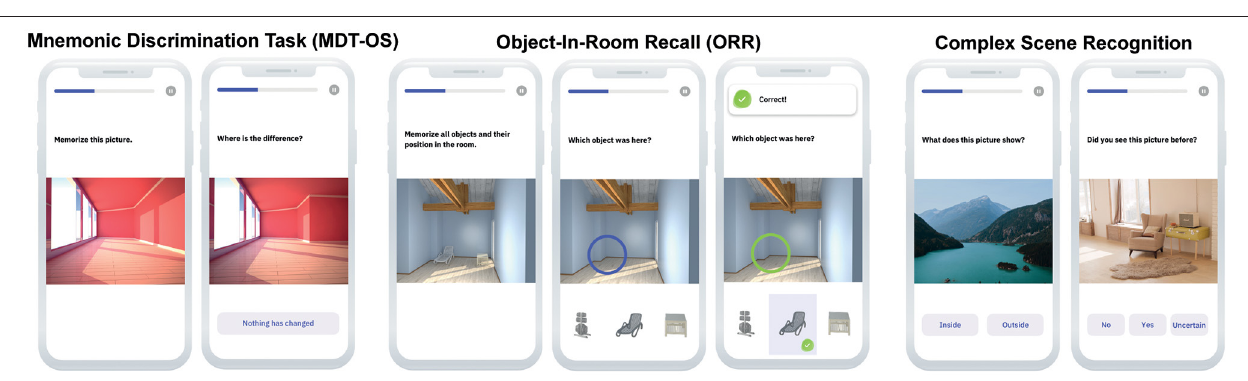
FIGURE 2 | Digital memory assessments. Mnemonic Discrimination Task for Objects and Scenes (MDT-OS), Objects-in-Room Recall (ORR) Test and Complex Scene Recognition Test (CSR).